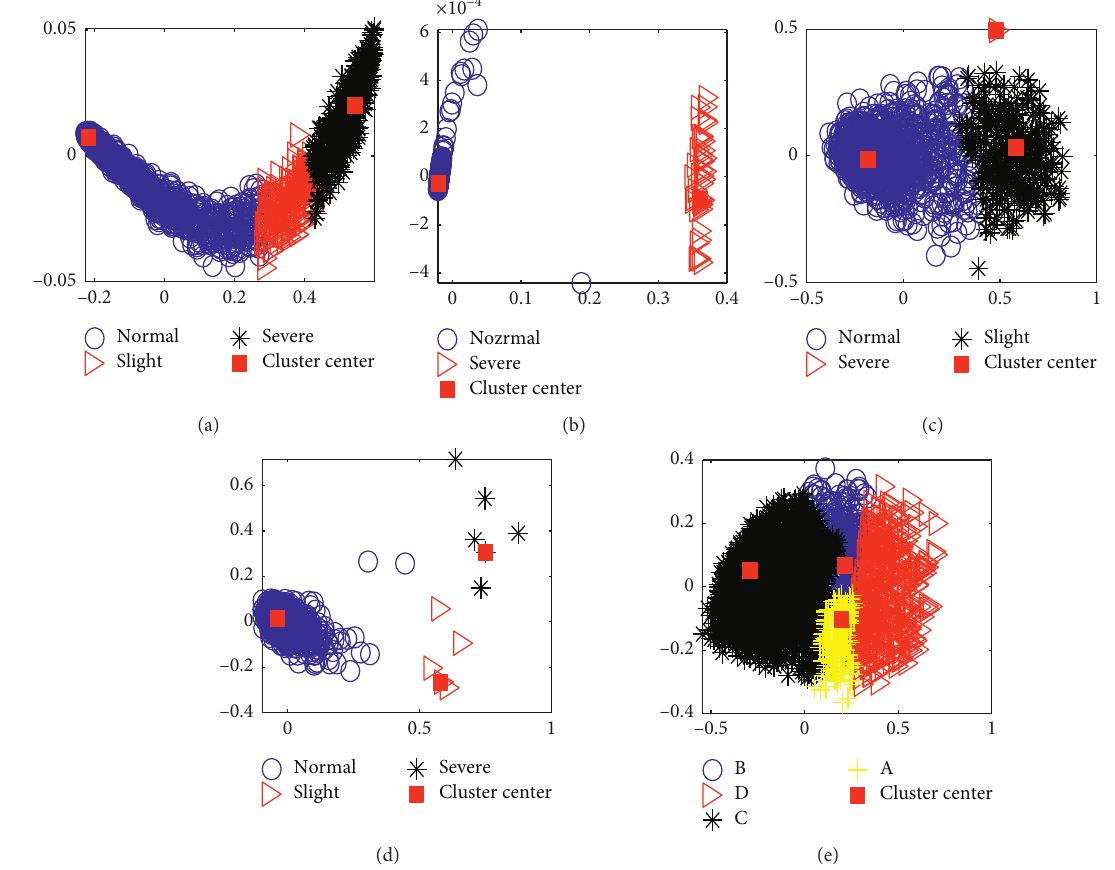
Figure 12: Two-dimensional clustering result by using the SAE and CFS for bearings 11–15. A: Normal1; B: Normal2; C: Slight; D: Severe. (a) CFS-bearing 11. (b) CFS-bearing 12. (c) CFS-bearing 13. (d) CFS-bearing 14. (e) CFS-bearing